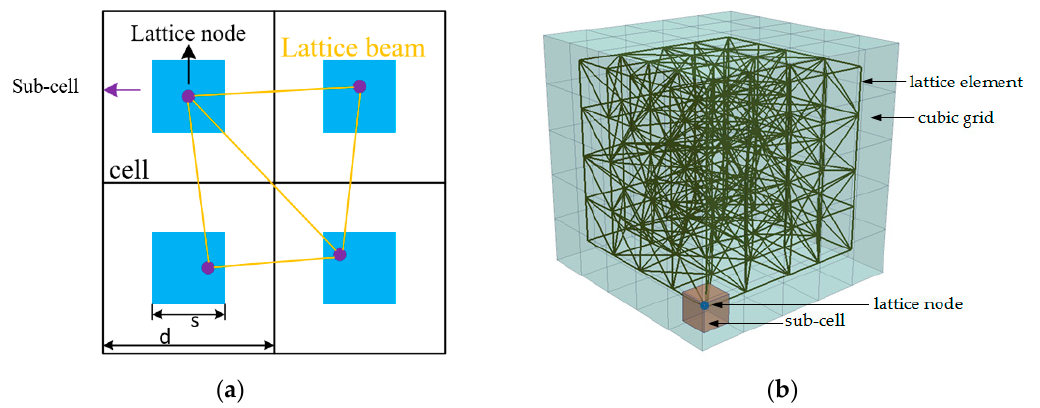
Figure 1. ( a ) Schematic view of LBM (lattice beam network model) generation; ( b ) node and mesh generation procedure using Delaunay triangulation. Reproduced from [20]. Copyright 2018, Elsevier.